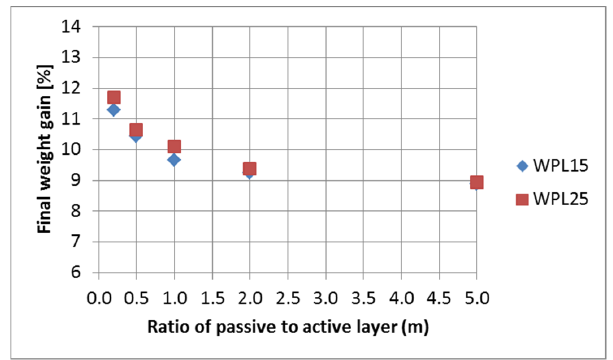
Figure 5. Final weight gain of the bilayered composite in relation to the thickness of the passive (PLA) to active (WPL) layer. (PLA) to active (WPL)